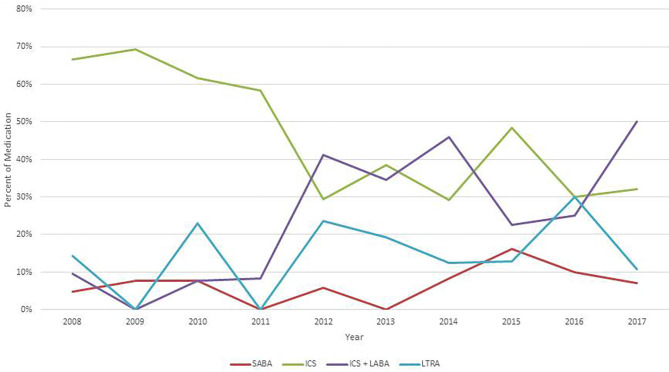
Medication at discharge 2008–2017. ICS, inhaled corticosteroids; LABA, long-acting β2-agonists; SABA, short-acting β2-agonists; LTRA, leukotriene receptor antagonist.